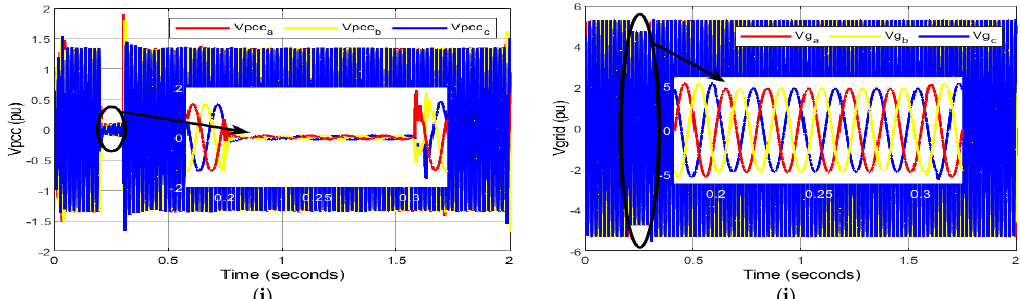
Figure 7. Behavior of DFIG-based WECS during three-phase fault without protection. ( a ) Per unit electromagnetic torque; ( b ) per unit stator voltage; ( c ) per unit stator current; ( d ) per unit rotor voltage; ( e ) per unit rotor current; ( f ) DC link voltage; ( g ) active power (MW); ( h ) reactive power (MVAr); ( i ) per unit voltage at PCC; ( j ) per unit grid voltage.